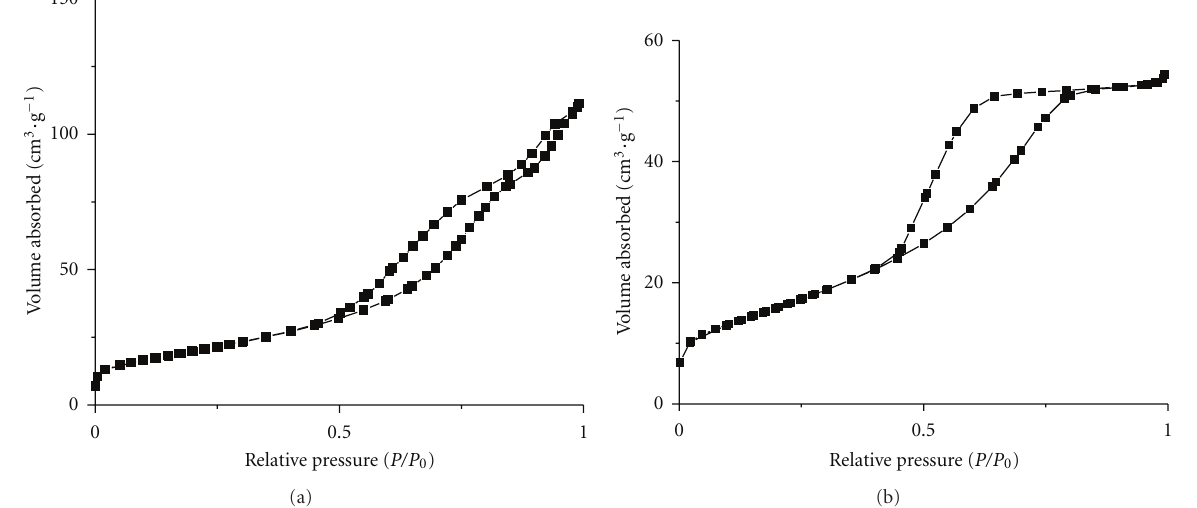
Figure 7: N 2 adsorption/desorption isotherms of pure TiO 2 (a) and Nd-doped TiO 2 with Ti:Nd = 11 :1 (b).